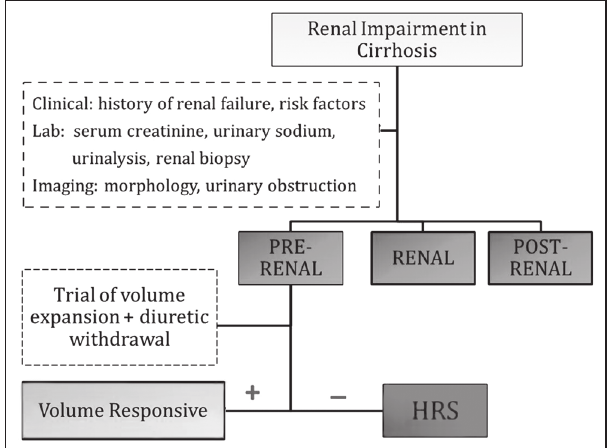
work-up of renal impairment in patients with cirrhosis. HRS Hepatorenal